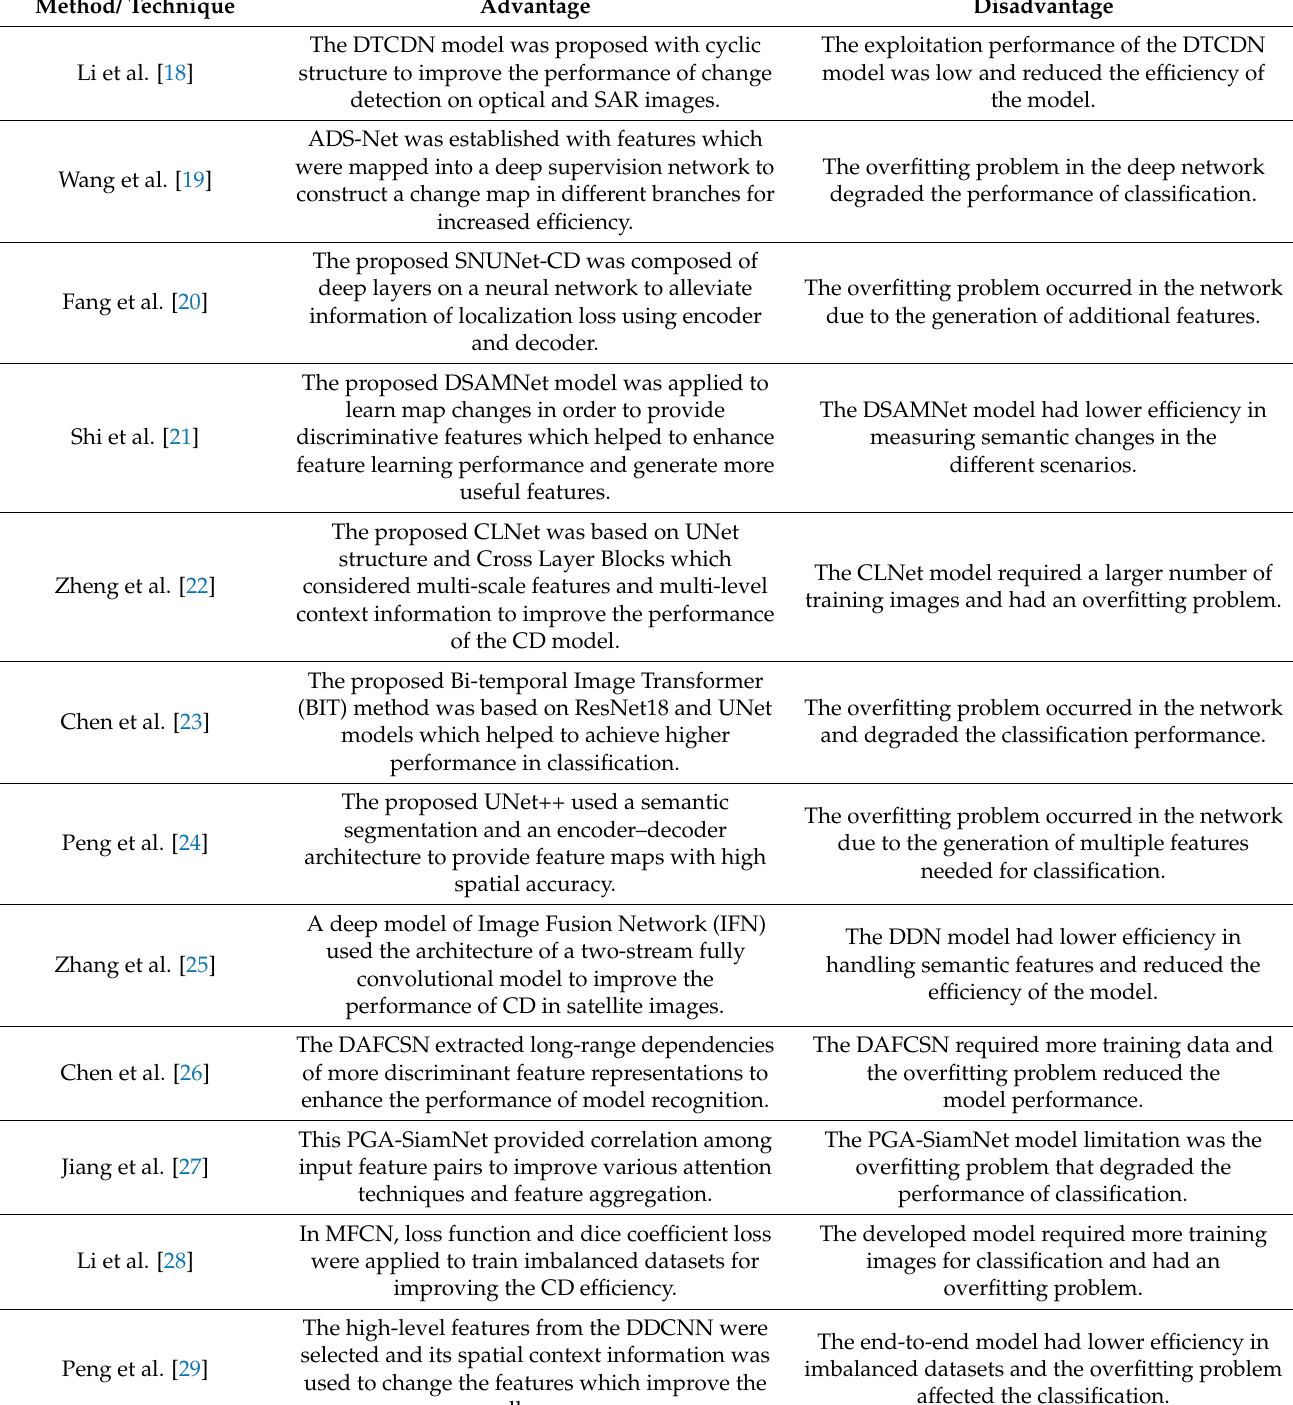
Table 1. Comparison of published works related to change detection under various